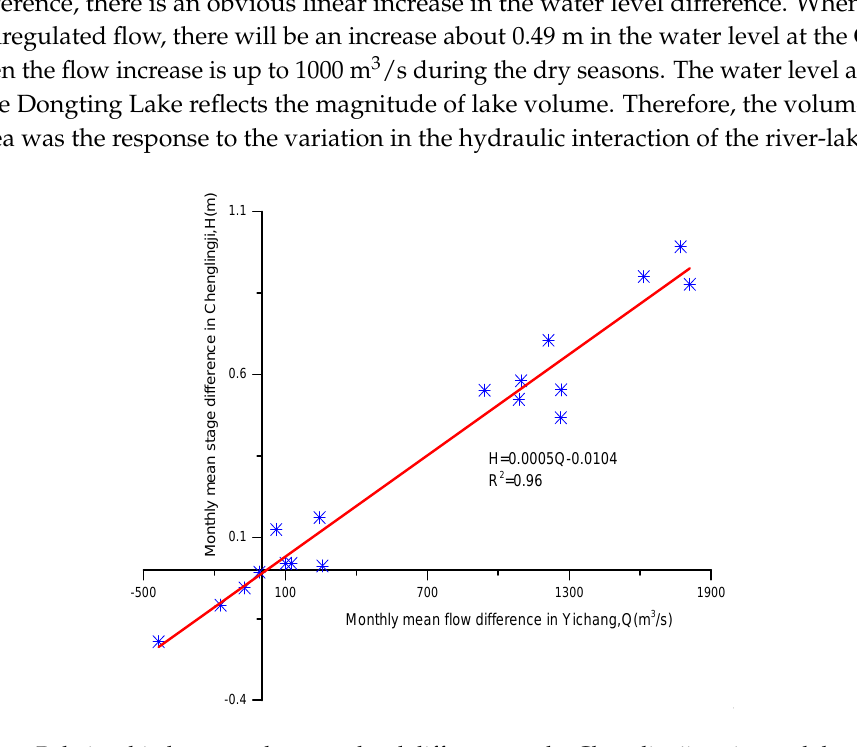
Figure 10. Relationship between the water level difference at the Chenglingji station and the outflow difference at the Yichang station with and without the TGR.